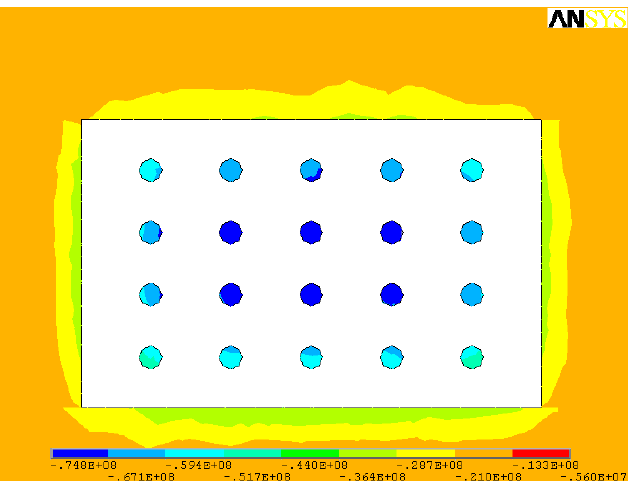
Figure 35. Maximum principal stress distribution of scheme 9 pillars at 1480 mL (parameters of scheme 9: stope height 4.5 m, pillar diameter 4 m, pillar spacing 7 m, pillar row spacing 8 m).